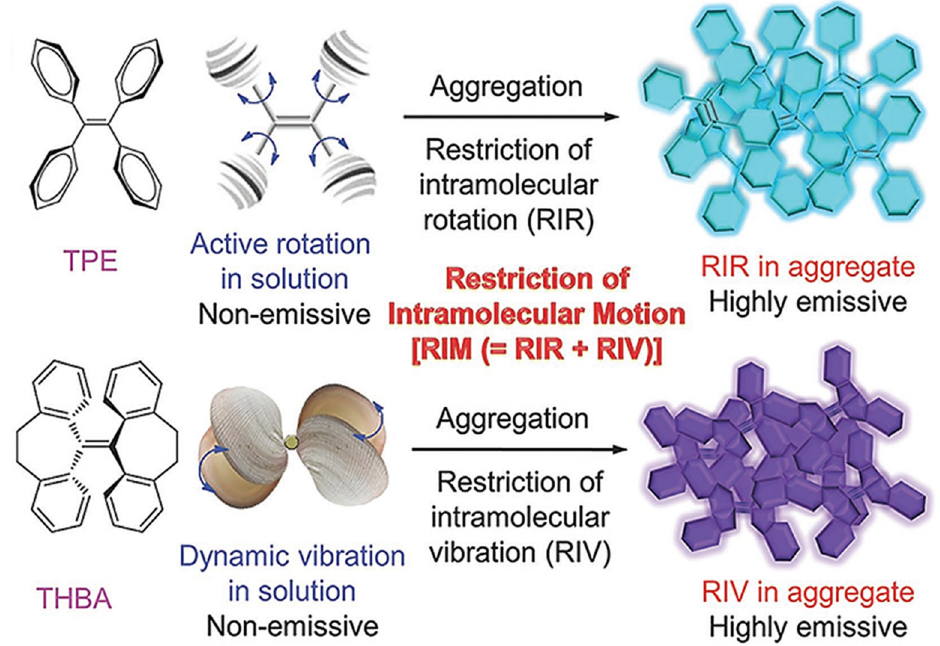
Figure 3. Representation of proposed mechanism for AIE effect. Reprinted from reference [29] with the permission of Wiley-VCH.